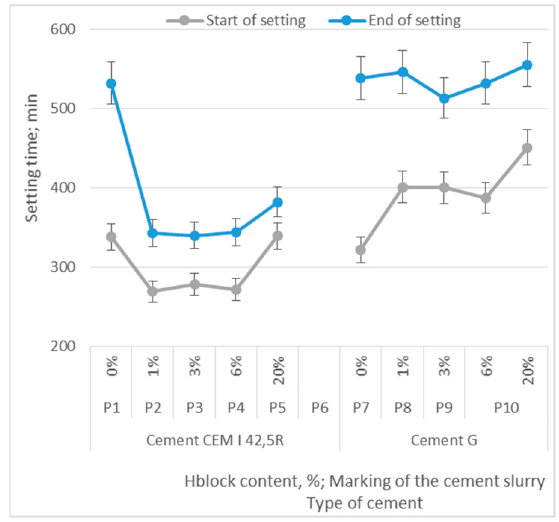
Figure 9. Summary of the setting time values of the tested cement slurries.